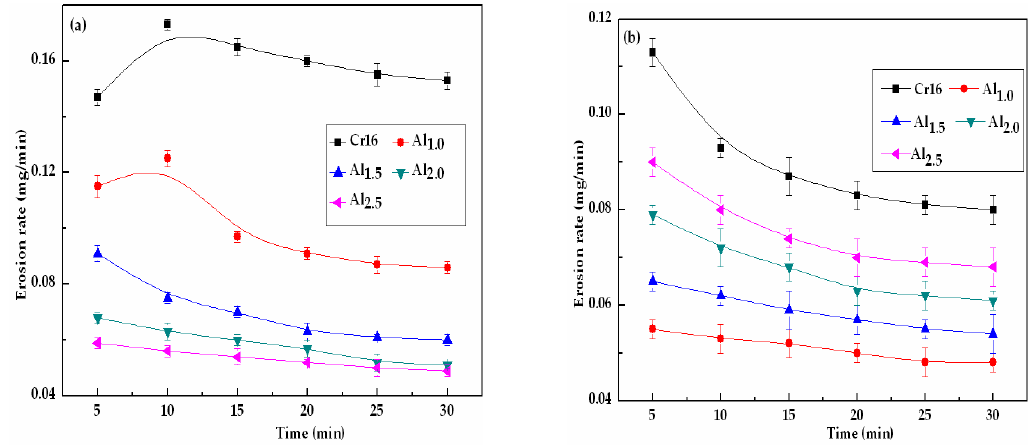
Figure 8. Variation in erosion rate of Al x CoCrFeNiTi 0.5 HEA coatings and Cr16 alloy with erosion time at a velocity of 10.08 m/s and impingement angle of ( a ) 45° and ( b ) 90°.